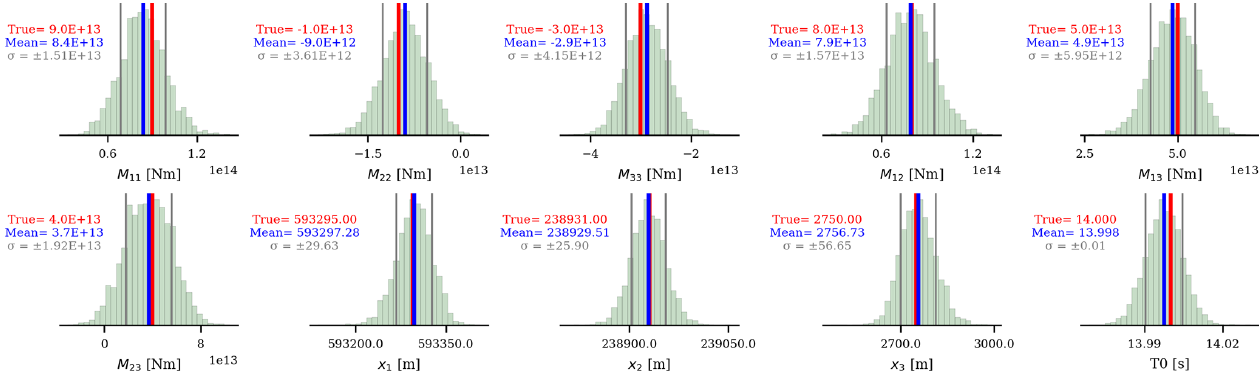
Figure 8. The final marginal posterior distributions (green samples in Fig. 7). The means are represented by the blue lines, and the gray lines are the standard deviations. Red lines are the true